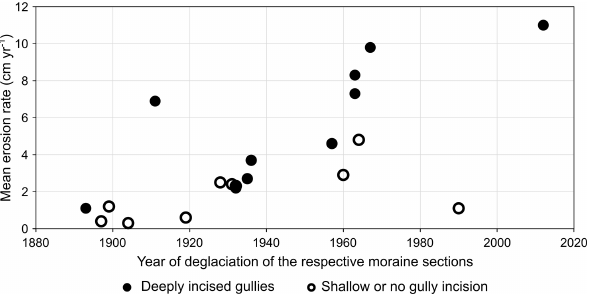
Figure 11. Mean erosion rates in time period 3 (see Table 4 for spe- cific DoDs) depending on the years of deglaciation of the moraine sections with deeply incised gullies and shallow (or no) gully inci- sion.